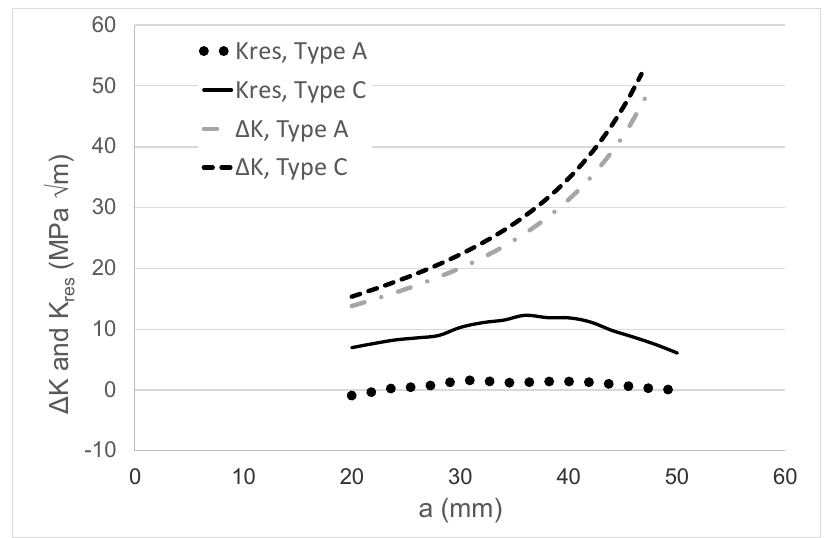
Figure 11. The relationship between the residual stress intensity factors and the crack length ( a ) as determined in [76] for the Type A and Type C specimens.